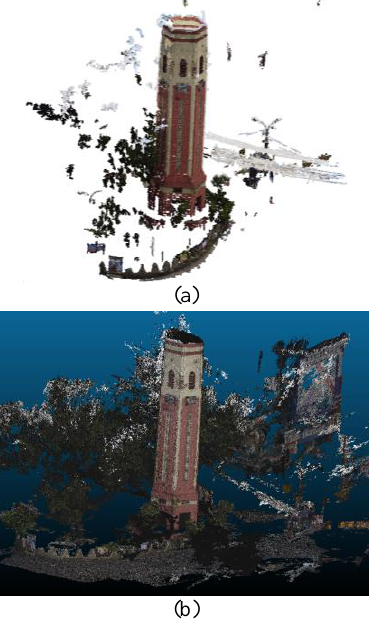
Figure 4. Dense reconstruction; (a) VSfM, (b)